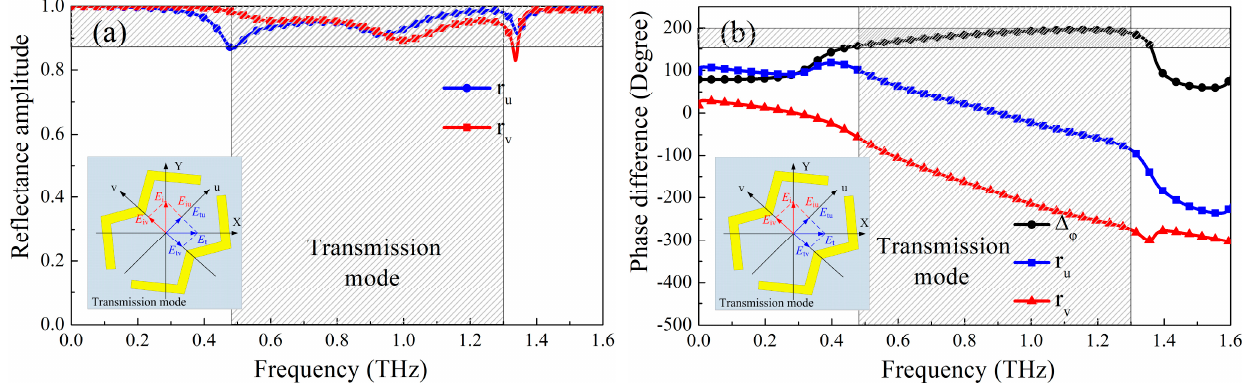
Figure 7. ( a ) Amplitudes and ( b ) phase of polarization conversion mode when the electric field of incident EM waves along the u-axis and v-axis for transmission mode, respectively.